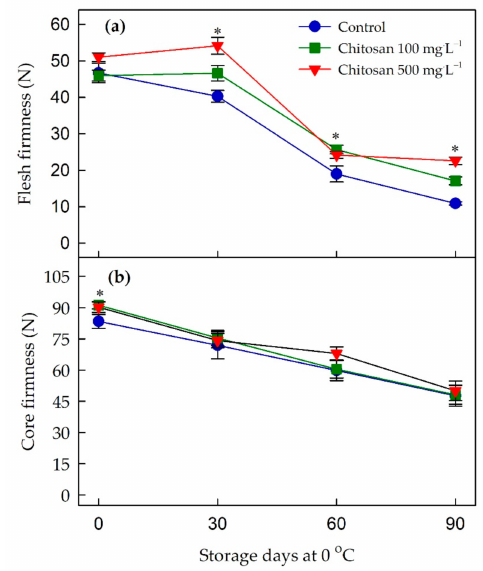
Figure 3. Effects of preharvest chitosan application on ( a ) flesh firmness and ( b ) core firmness during cold storage in ‘Garmrok’ kiwifruit. Vertical bars indicate SE with n = 10. * indicates significant differences between treatments at each sampling date, according to the least significant difference (LSD) test at p ≤